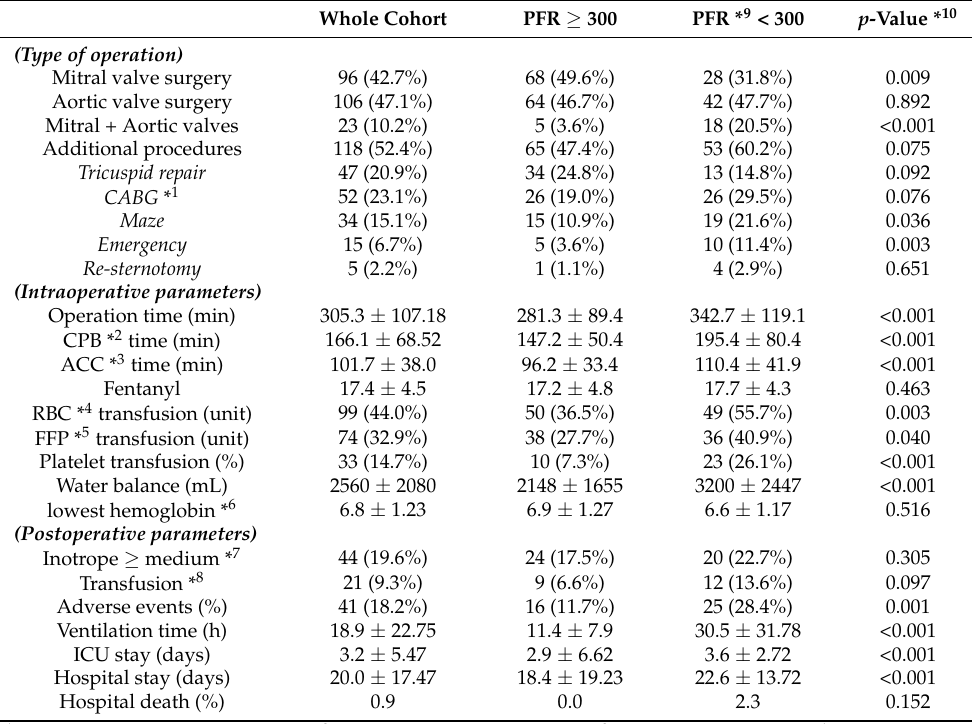
Table 2. Intraoperative parameters and postoperative